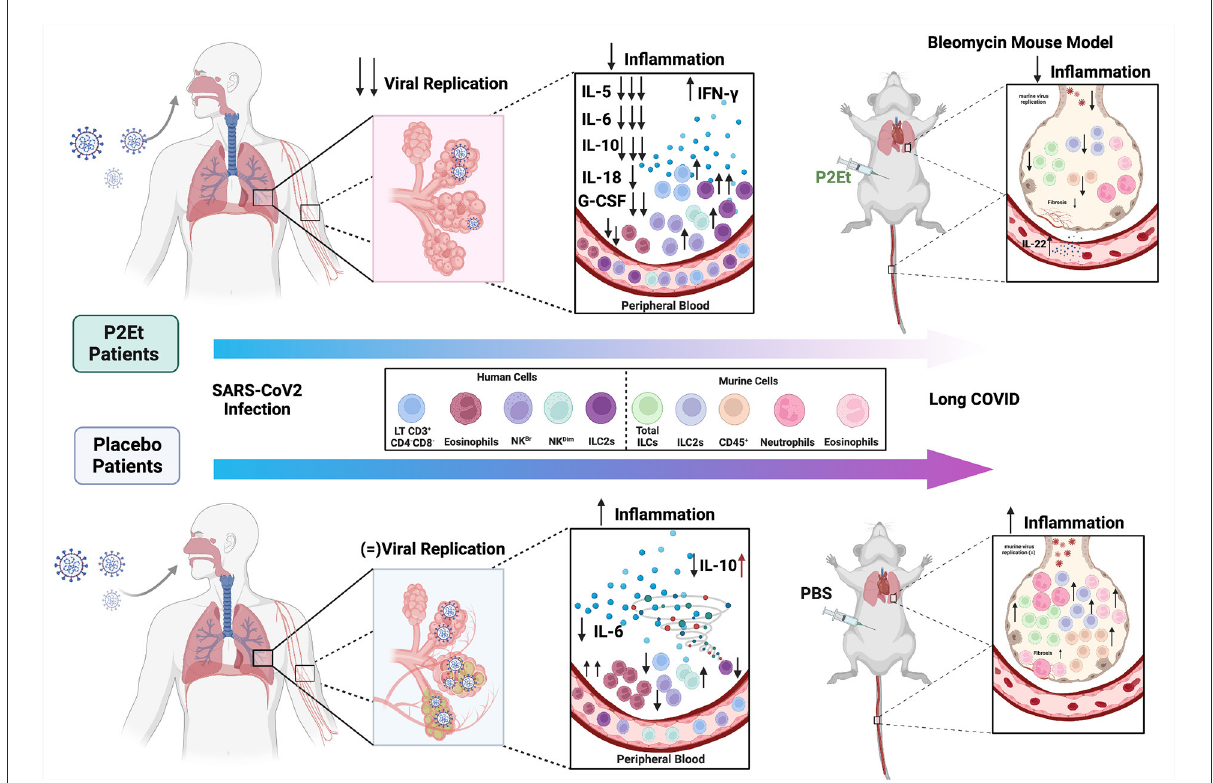
FIGURE6 Proposed model for the P2Et effect in COVID-19. COVID-19 patients (moderate or severe) were treated with P2Et or Placebo. P2Et treatment (upper left) decreases ex vivo viral replication as well as proinflammatory cytokines such as IL-5, IL-6, IL-10, IL-18, G-CSF, and increases IFN- γ in peripheral blood. A decrease in eosinophils and an increase in other cell populations such as LT CD3 + CD4-CD8-, NK Br , NK Dim , and ILC2s are observed. The upper right image shows the effect of P2Et treatment in a mouse model of bleomycin-induced pulmonary fibrosis. In the lung, it decreases CD45 + cells, total ILC, ILC-2, eosinophils, and neutrophils. In peripheral blood it increases the production of IL-22. In summary, P2Et treatment regulates the inflammation induced by SARS-CoV-2 infection, modulating factors related to long-term clinical manifestations. The lower left image shows the effect of Placebo treatment in patients with COVID-19. A slight decrease in IL-6 and IL-10 is observed in moderate patients but an increase in IL-10 in severe patients. For the other cytokines (IL-5, IL-18, G-CSF, and IFN- γ ) no significant changes are